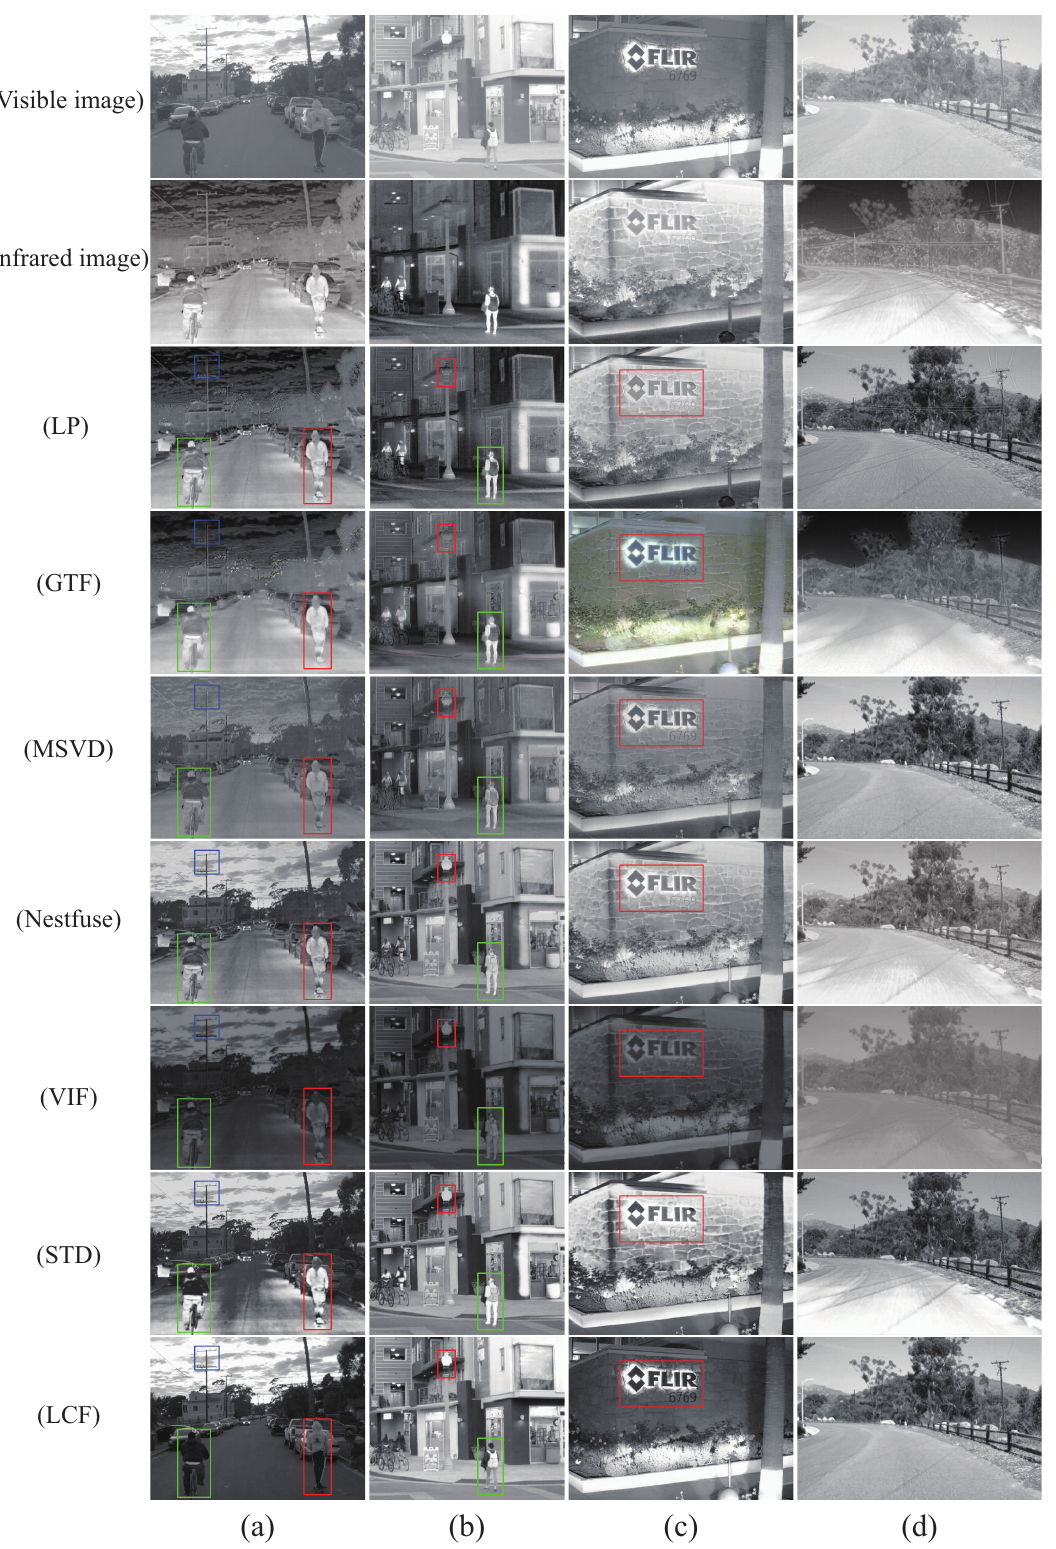
Figure 5. Qualitative comparison of LCF with six state-of-the-art methods on a street. Each row is an image from the RoadScene dataset ( a – d ). For a clear comparison, we select a salient region (i.e., the red box, the green box, the blue box) in each image and enlarge it in the bottom right corner. From top to bottom, each row is as follows: Visible image. Infrared image. LP. GTF. MSVD. Nestfuse. VIF. STD.